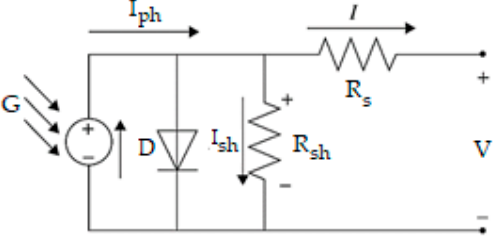
Figure 1. Equivalent photocell circuit diagram